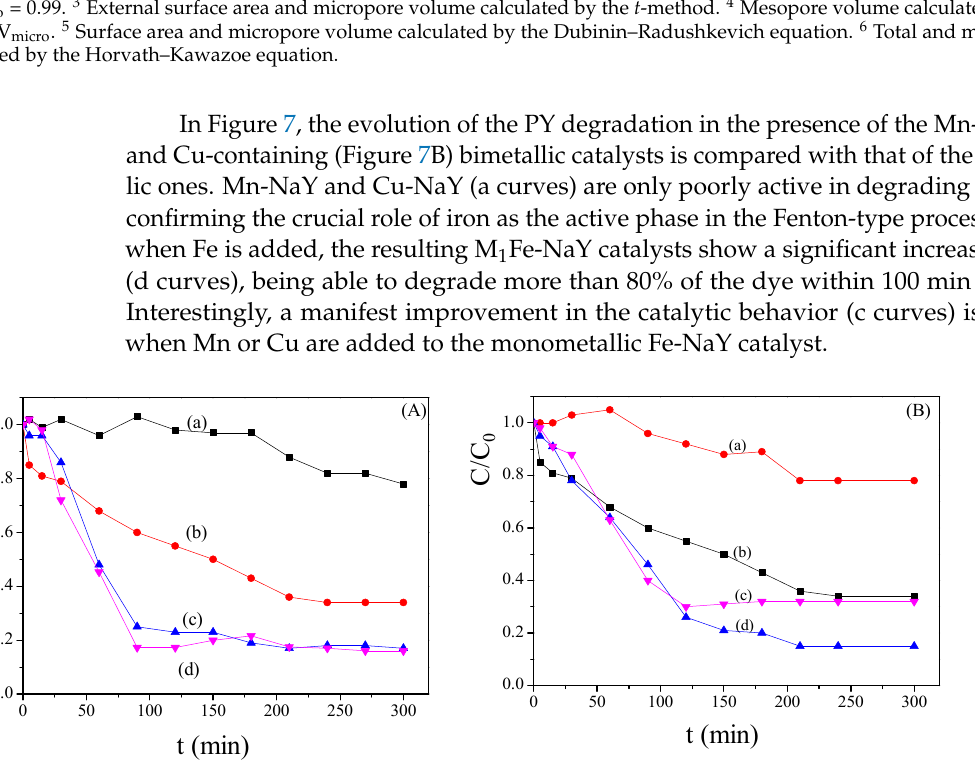
1 Specific surface area calculated from the BET (Brunauer–Emmett–Teller) equation. 2 Total pore volume determined from the amount adsorbed at P/P o = 0.99. 3 External surface area and micropore volume calculated by the t -method. 4 Mesopore volume calculated by the difference V total -V micro . 5 Surface area and micropore volume calculated by the Dubinin–Radush- kevich equation. 6 Total and micropore volumes calculated by the Horvath–Kawazoe equation.